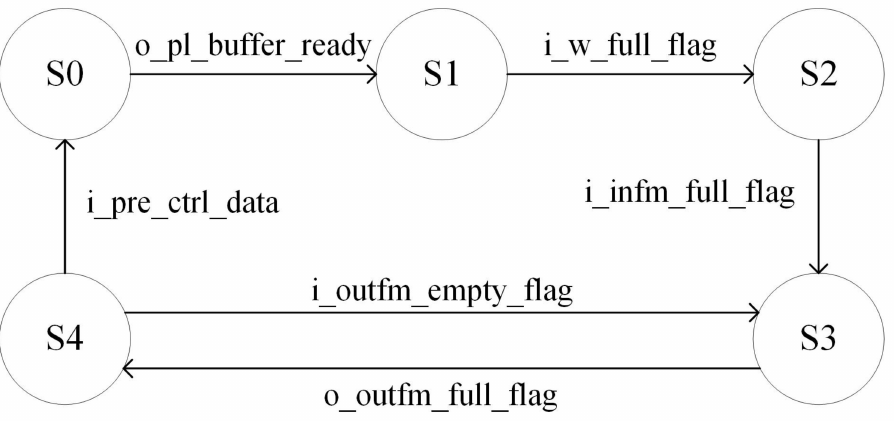
Figure 8. Finite State Machine of convolution